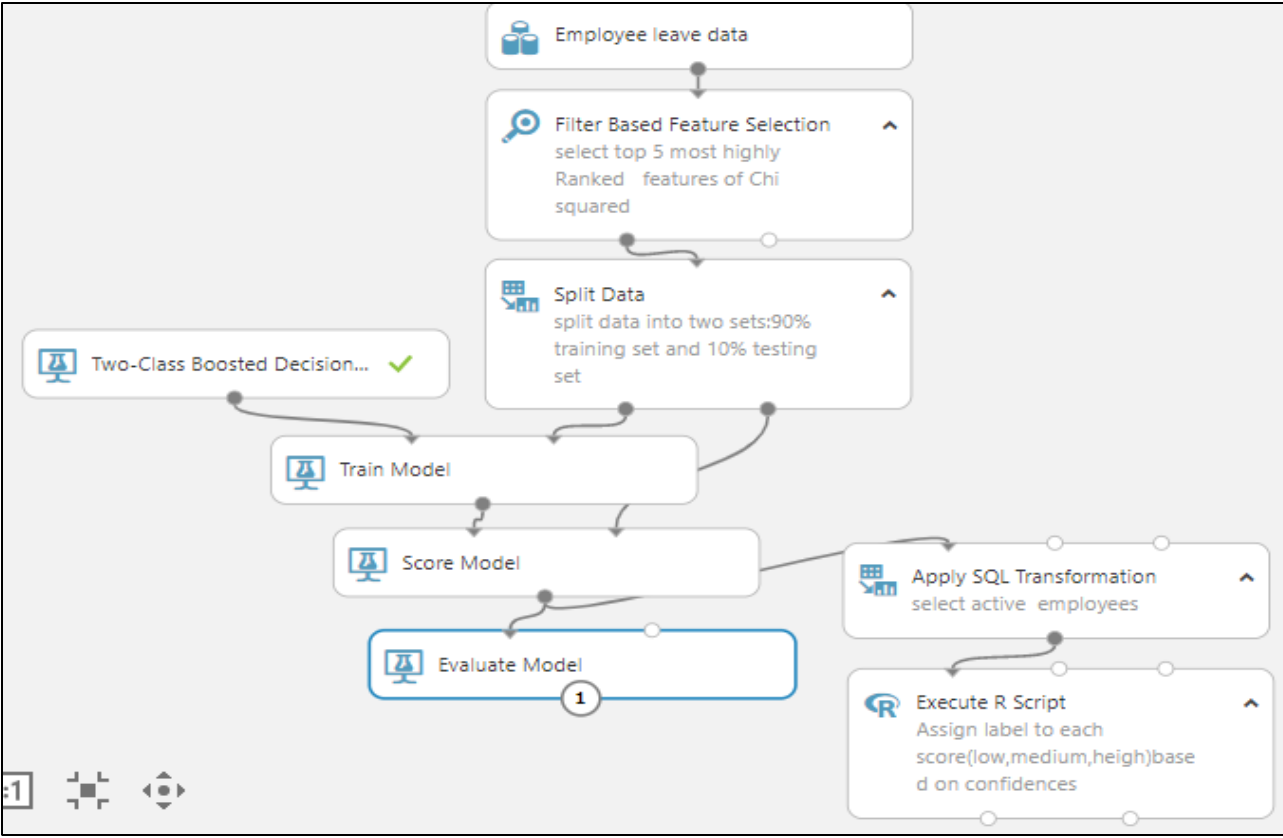
Figure 22. Risk model prediction of employee churn.